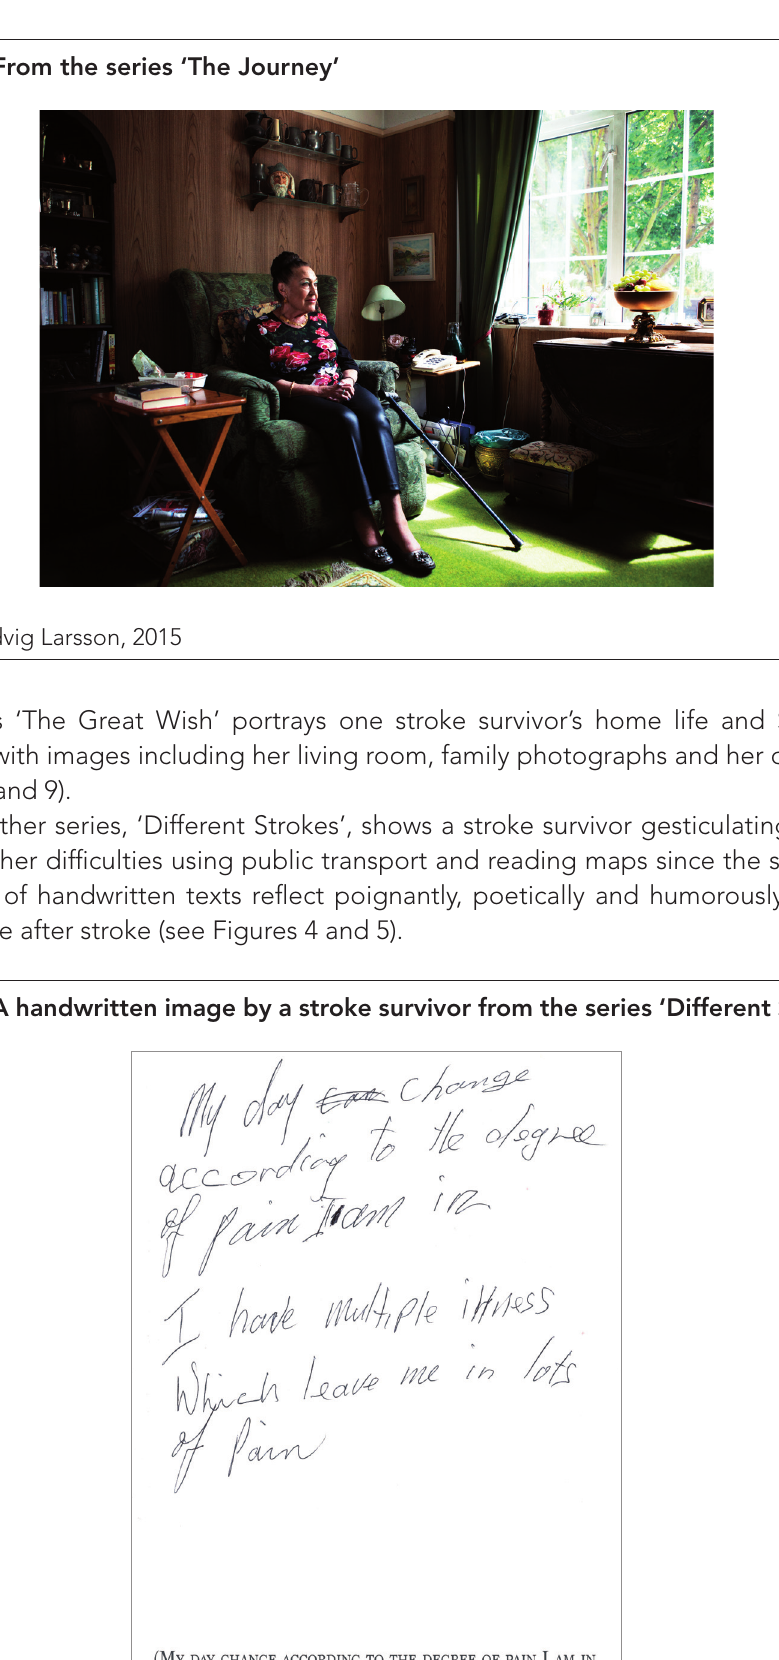
Figure 3: From the series ‘The Journey’